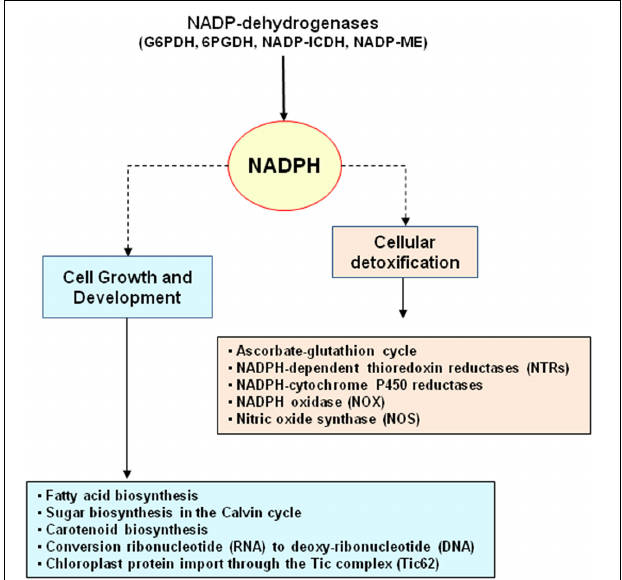
FIGURE 1 | NADP-dehydrogenases as enzymatic sources of NAPDH in plant cells and its implications in cellular detoxification, cell growth and